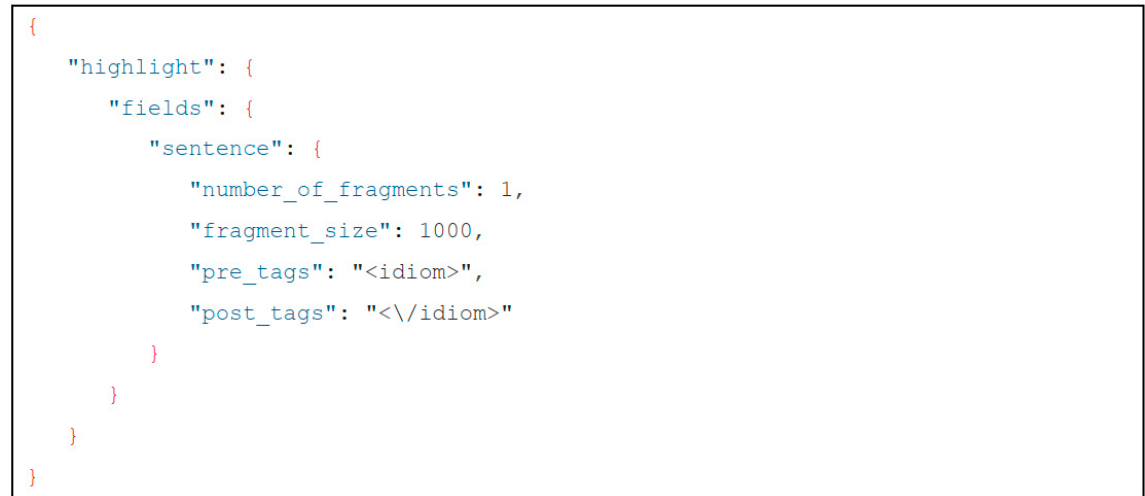
Figure 10. Highlighting matching snippets in the search results.